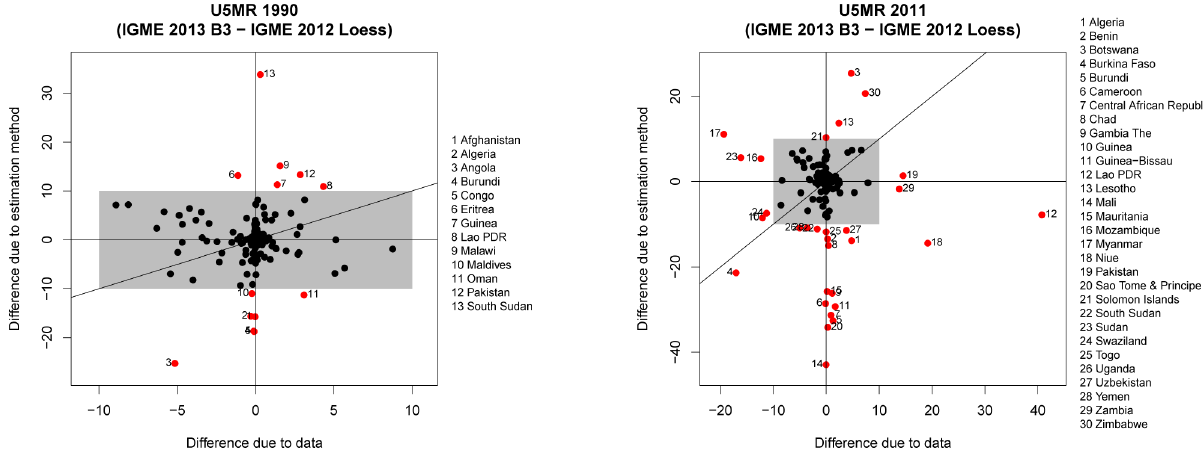
Figure 4. Decomposition of differences in U5MR for 1990 and 2011 into differences due to estimation method and differences due to data. The gray box represents differences up to 10 deaths per 1,000 live births. Countries with differences of more than 10 deaths per 1,000 deaths due to either factor are highlighted in red.